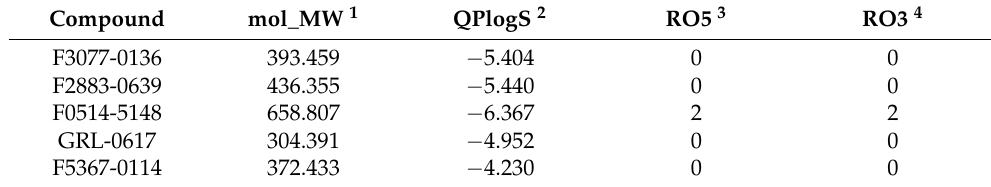
Table 3. Selected Qikprop descriptors for the top three compounds and the control